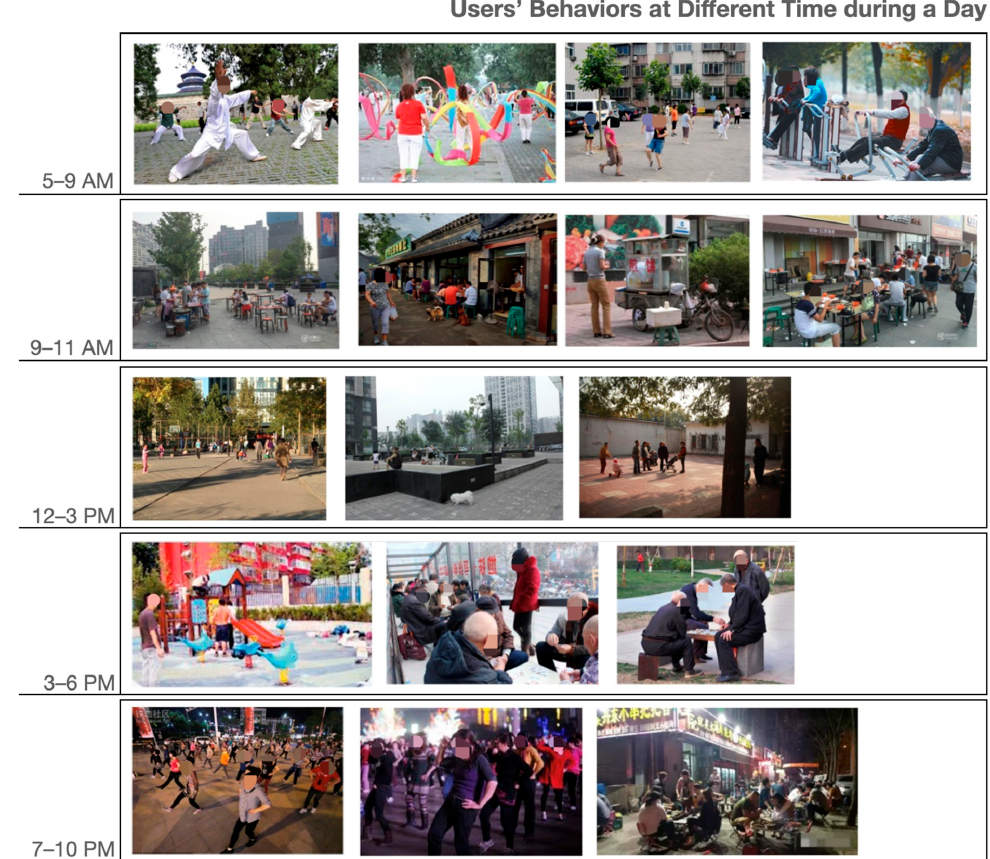
Figure 4. Users’ behaviours at different times of day.